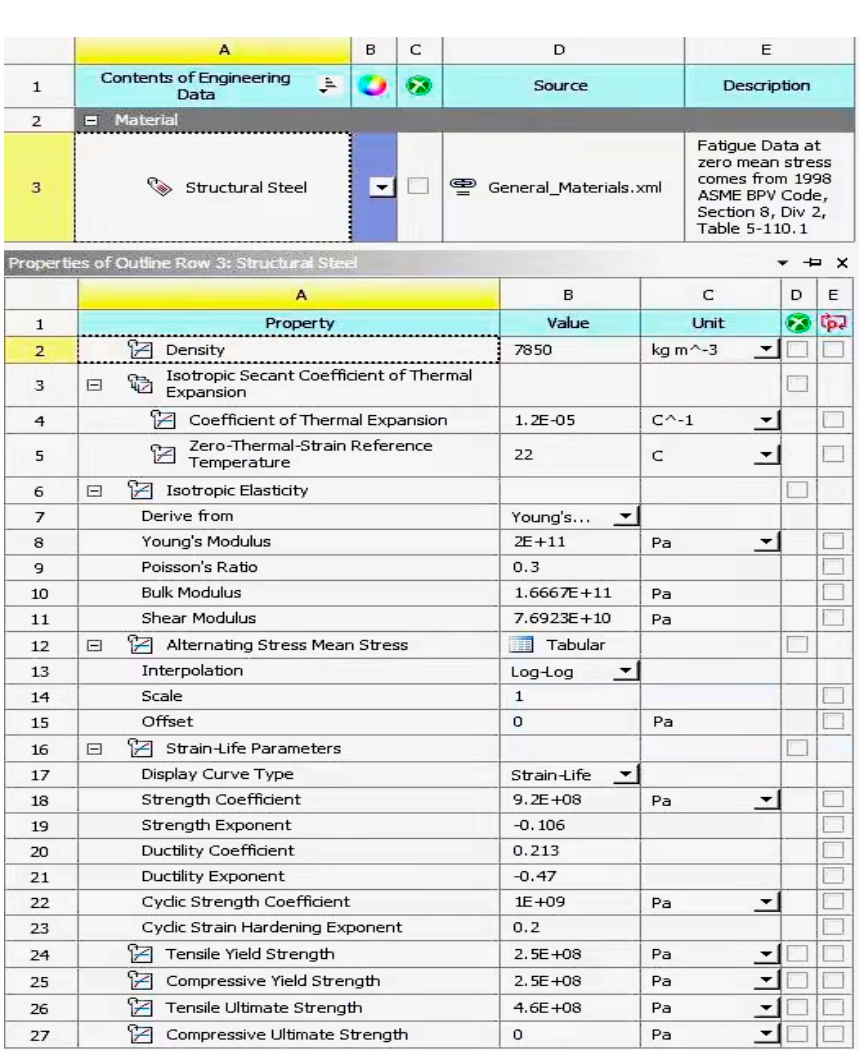
Figure 4. Material characteristics of the finite element model and test piece.